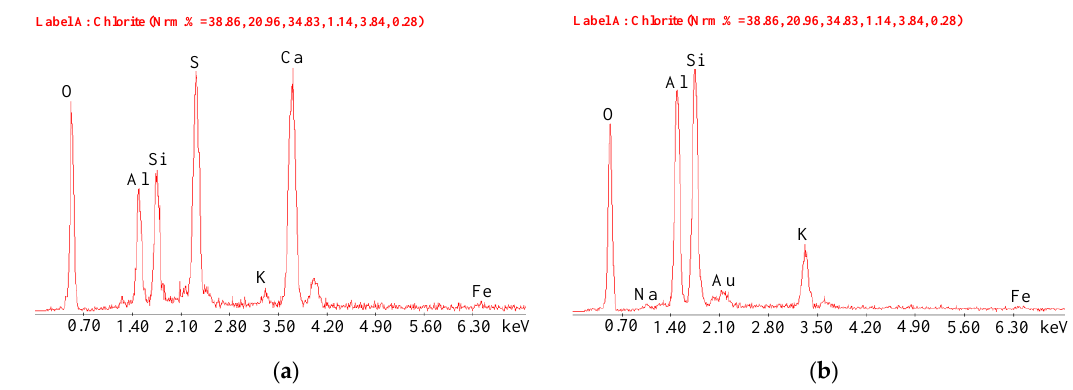
Figure 3. Energy spectrum analysis of rock sample: ( a ) Pattern 1; ( b ) Pattern 2.